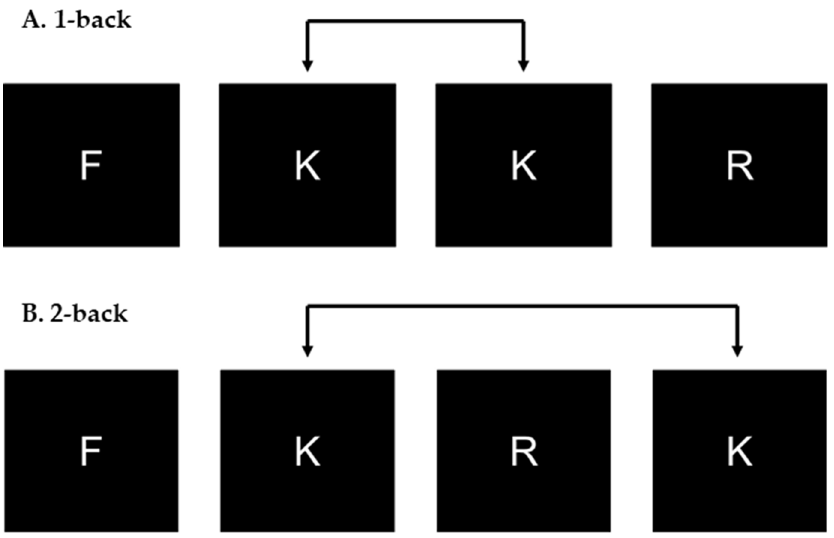
Figure 3. N-back task. ( A ) Presented a 1-back condition trial. ( B ) Presented a 2-back condition